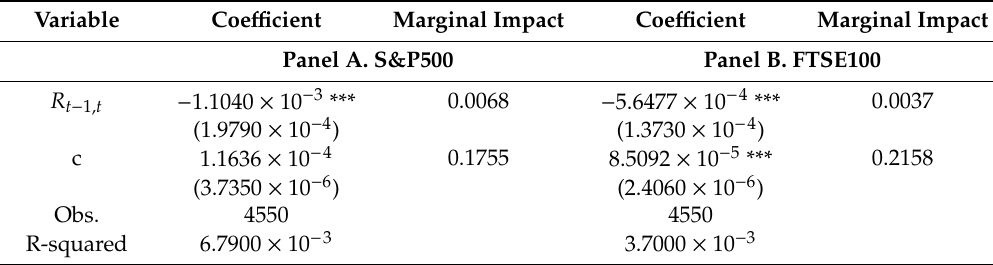
Table 3. Hypothesis 2 (leverage e ff ect) regression